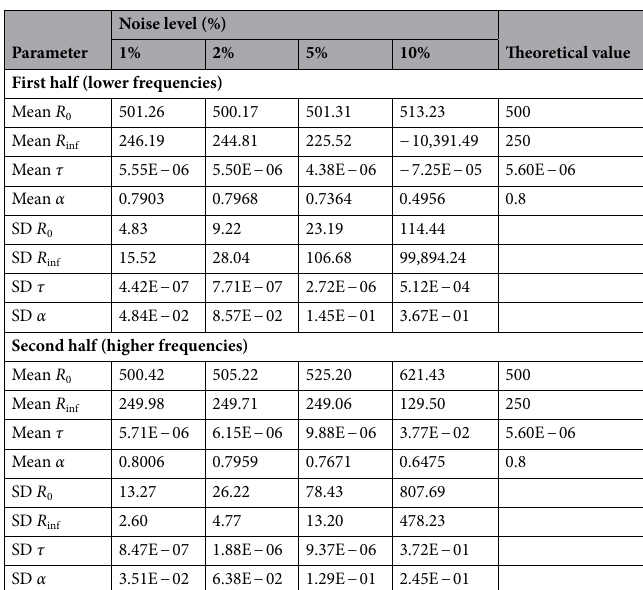
Table 7. Parameters obtained by the 3P method with simulated spectra created with different percentages of added noise. Form 2.